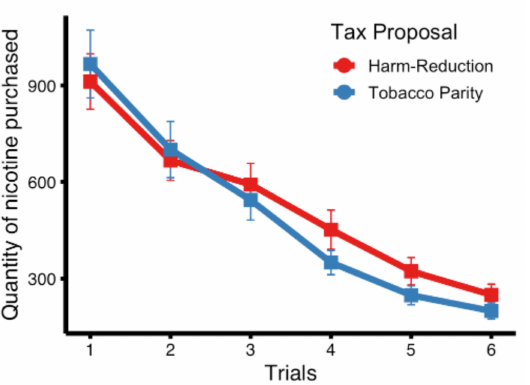
Figure 1. Total nicotine (mg) purchased in the tobacco parity and harm reduction tax proposals across